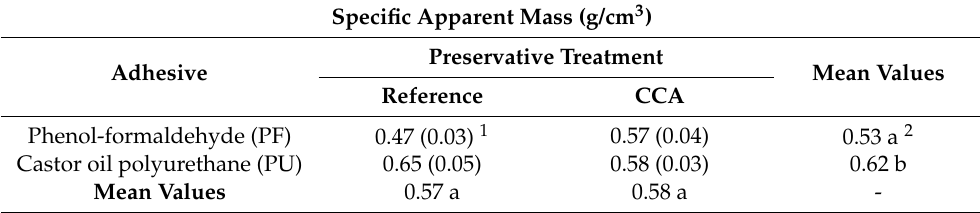
Table 3. Results: specific apparent